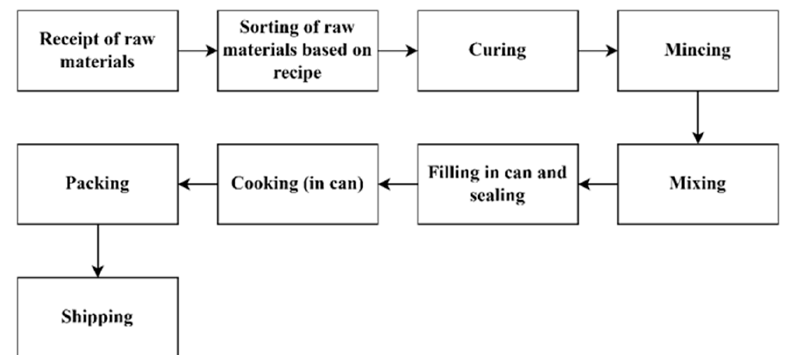
Figure 8. Case-study canning process.